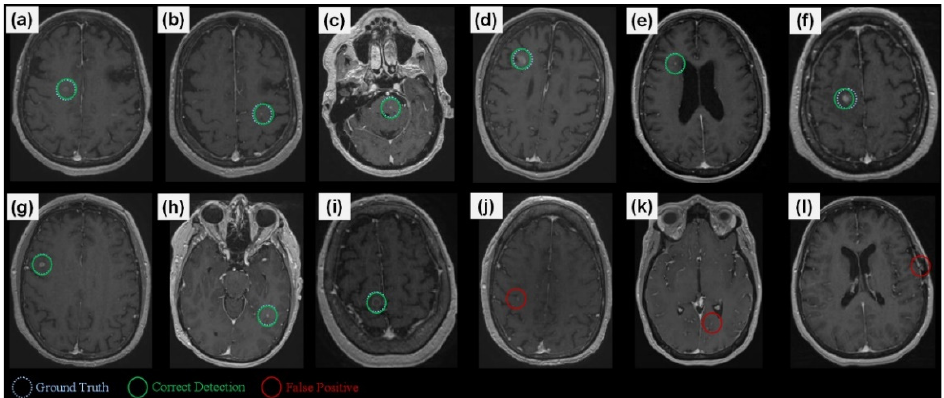
Figure 6. A set of detection examples. ( a – i ) Correct BM detections, ( j , k ) small vessels are wrongly detected as BMs, and ( l ) a formation in a surgical region is detected as a BM. The framework processes a given exam by first generating candidates and then processes these via CropNet, where the high response candidates are presented as the detection results.